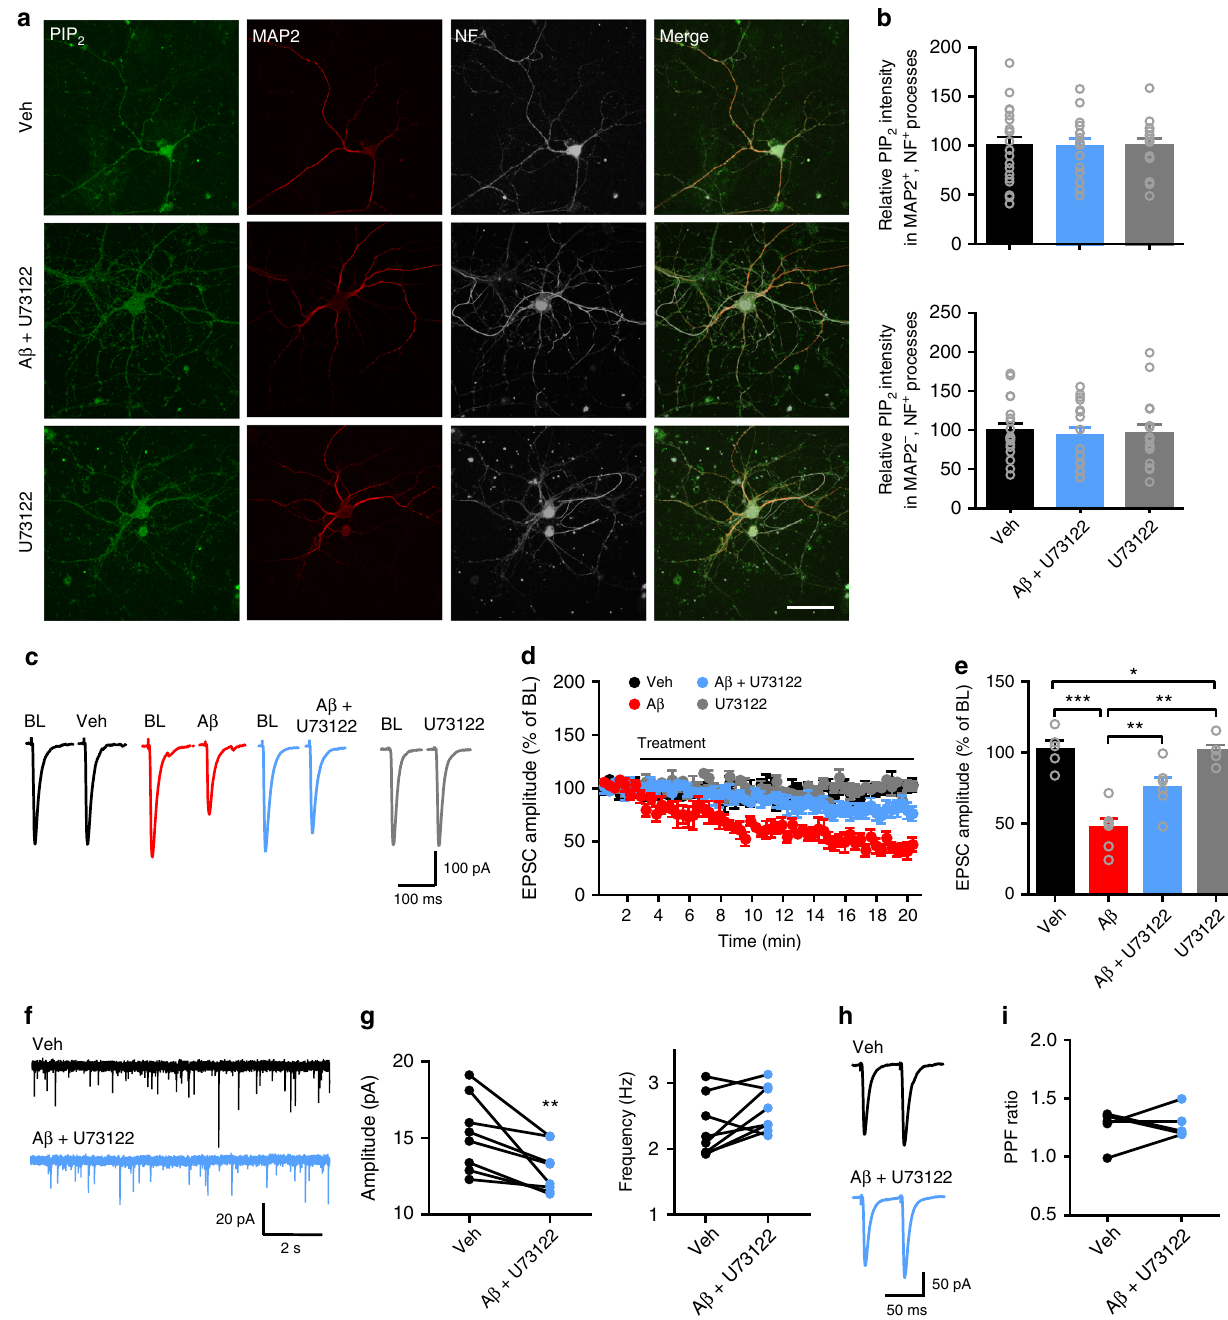
Fig. 5 Oligomeric A β -induced PIP 2 reduction and presynaptic de fi cit are prevented by inhibiting PLC. a Confocal images of primary hippocampal neurons showing the effect of oligomeric A β on PIP 2 levels in neuronal processes in the presence of PLC blocker U73122. Bar, 50 μ m. b Quanti fi cation of relative PIP 2 intensity in dendrites (upper panel) and axons (bottom panel) showing U73122 prevents A β -induced suppression of PIP 2 in neuronal processes. One-way ANOVA with post hoc Dunnett ’ s test; F (2,49) = 0.007 (upper); F (2,49) = 0.12 (bottom); P > 0.05; N = 16 – 20 per group. c , d Representative traces ( c ) and the time course of the normalized amplitude ( d ) of SC-CA1 EPSCs in WT hippocampal slices before (baseline, BL) and after Veh, A β , A β + U73122, or U73122 treatment. e Bar graph representing the relative magnitude of EPSCs recorded in the last 1 min of drug treatment shown in d . One-way ANOVA with post hoc Dunnett ’ s test; F (3,21) = 18.04; * P < 0.05; ** P < 0.01; *** P < 0.001; N = 5 – 6 per groups. f , g Representative traces ( f ) and quanti fi cation ( g ) of mean values of the amplitude (left) and frequency (right) of mEPSCs in CA1 pyramidal neurons before (Veh) and after A β + U73122 treatment. t test; ** P < 0.01; N = 8 per group. h , i Representative traces ( h ) and quanti fi cation ( i ) of PPF of SC-CA1 EPSCs before (Veh) and after A β + U73122 treatment. t test; P > 0.05; N = 5 per group. Data are mean ± SEM. Source data are provided as a Source Data fi